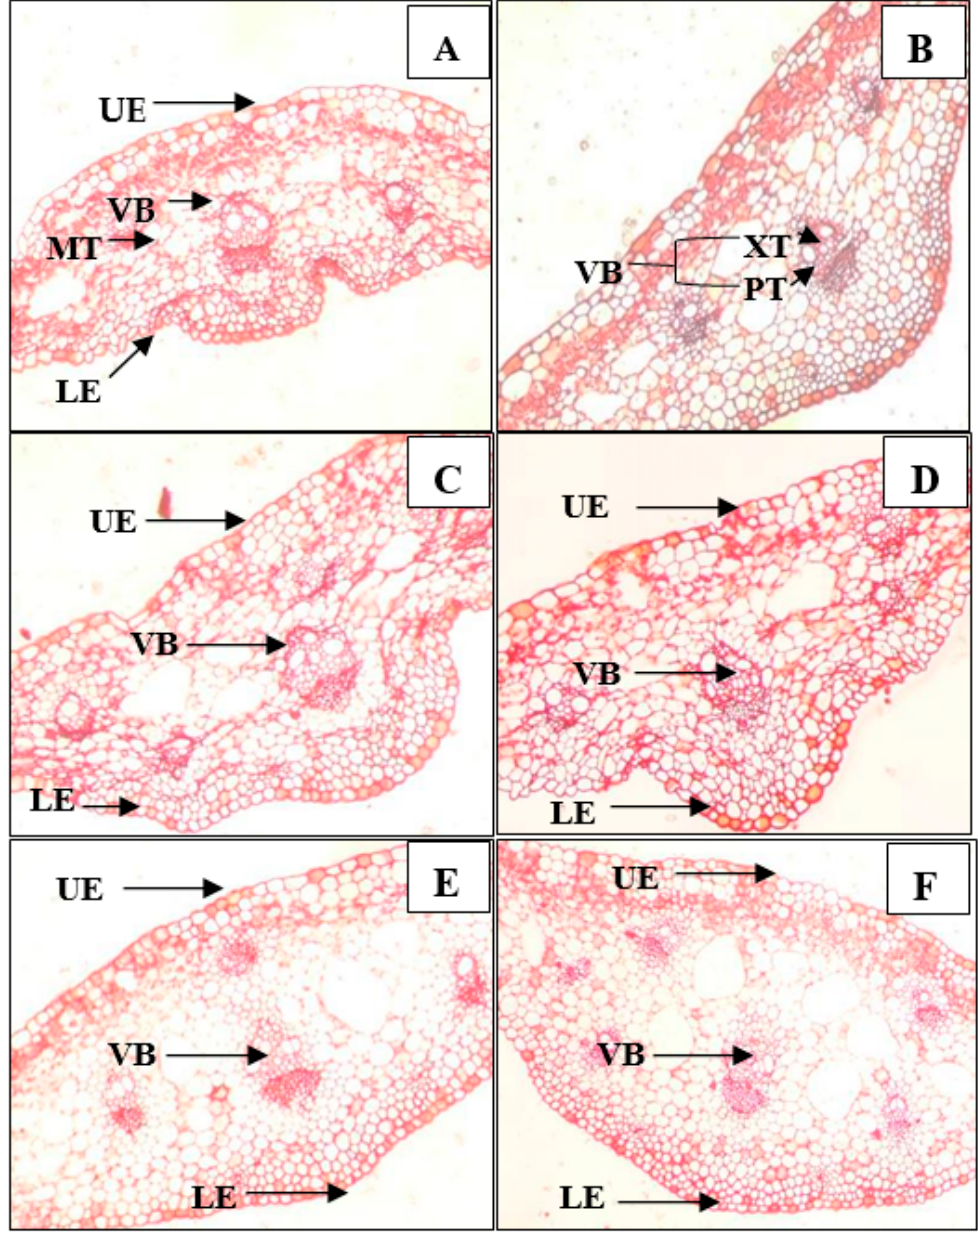
Figure 5. Anatomical structure of Philodendron bipinnatifidum leaves in the second season. ( A ): control, ( B ): NPK NPs at 2 ml/L, ( C ): ZnNPs at 200 mg/L, ( D ): SNPs at 20 mg/L, ( E ): SNPs at 40 mg/L, ( F ): SNPs at 60 mg/L, UE: Upper epidermis, MT: Mesophyll tissue, VB: Vascular bundle, XT: Xylem tissue, PT: Phloem tissue, LE: Lower epidermis (Magnification 100×).